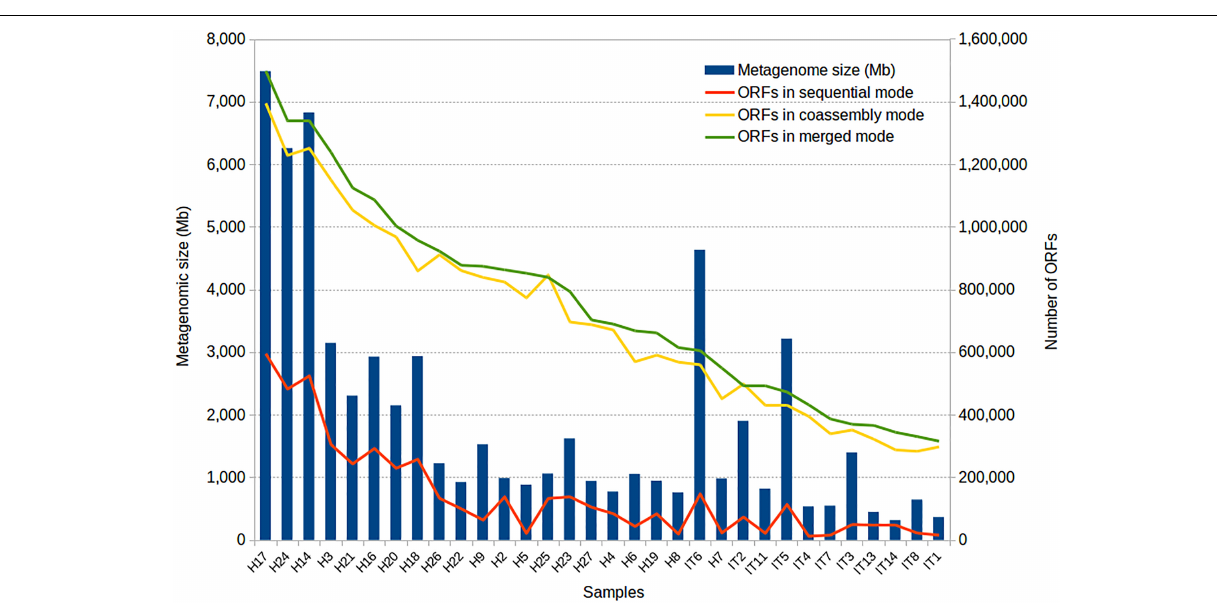
is 829.163.742. We used a 64-CPU computer cluster with 756